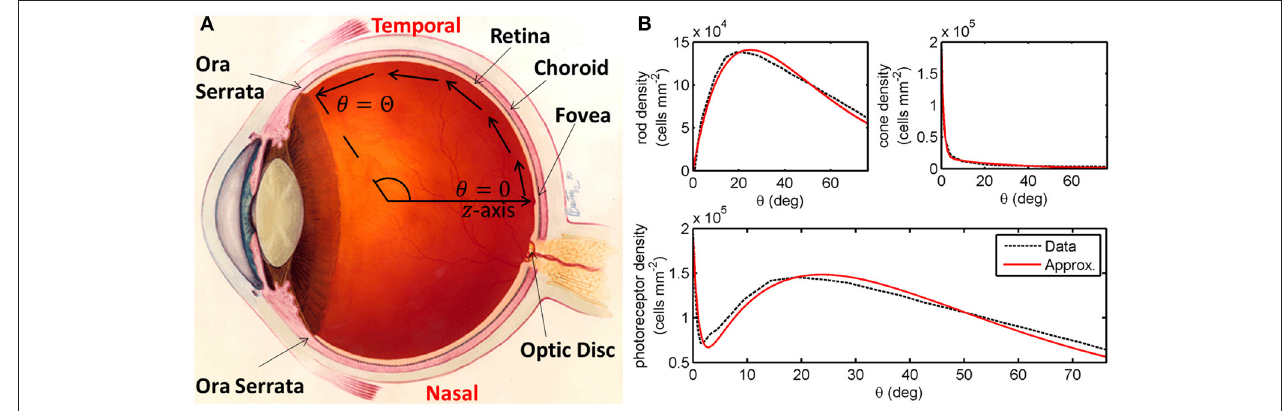
FIGURE 1 | Diagrams of the human eye and retinal photoreceptor distribution (reproduced, with permission, from Roberts et al., 2017). (A) Diagram of the (right) human eye, viewed in the transverse plane, illustrating the mathematical model geometry. The model is posed on a domain spanning the region between the foveal centre, at θ = 0, and the ora serrata, at θ = 2 , along the temporal horizontal meridian, where θ measures the eccentricity. Figure originally reproduced, with modifications, from http://www.nei.nih.gov/health/coloboma/coloboma.asp, courtesy: National Eye Institute, National Institutes of Health (NEI/NIH). (B) Measured and fitted photoreceptor profiles, along the temporal horizontal meridian, in the human retina. Cone profile: ˜ p c ( θ ) = B 1 e − b 1 θ + B 2 e − b 2 θ , and rod profile: ˜ p r ( θ ) = B 3 θ e − b 3 θ (see Table 2 for dimensionless parameter values). The photoreceptor profile is the sum of the rod and cone profiles ( ˜ p r ( θ ) + ˜ p c ( θ )). Experimental data provided by Curcio and published in Curcio et al. (1990).